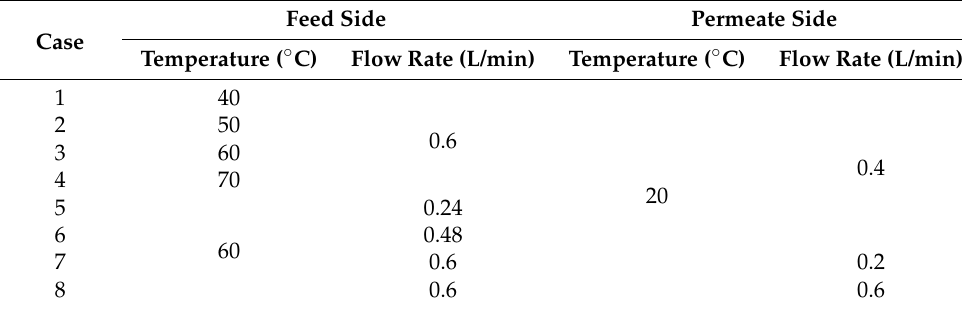
Table 2. Operating conditions for CFD simulation cases.